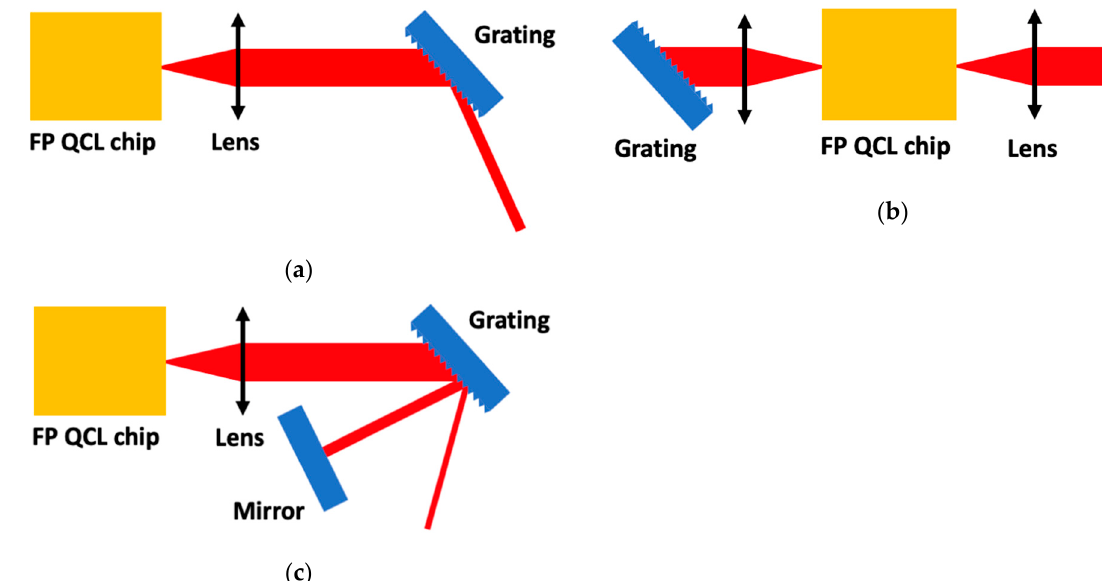
Figure 7. Schematic of Fabry–Pérot Quantum Cascade Laser chip source in an external-cavity system in ( a ) front facet Littrow configuration, ( b ) back facet Littrow configuration and ( c ) front facet Littman configuration.